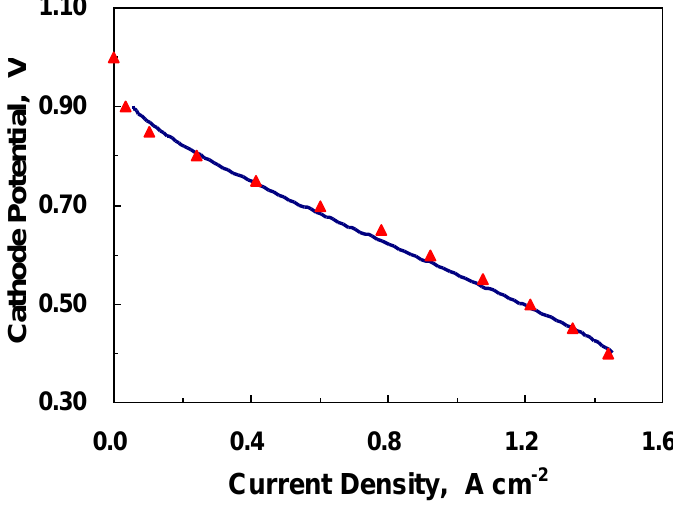
Figure 2. Polarization curve, electrode potential versus current density curve. The  is experimental data from reference [32] and the line is calculated results of this model.